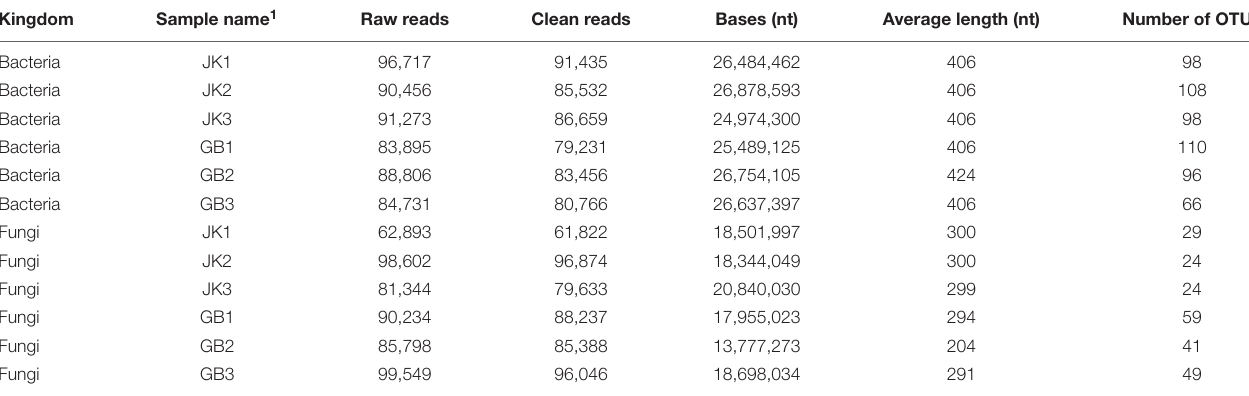
TABLE 1 | Metagenetic sequence data from different samples of tobacco